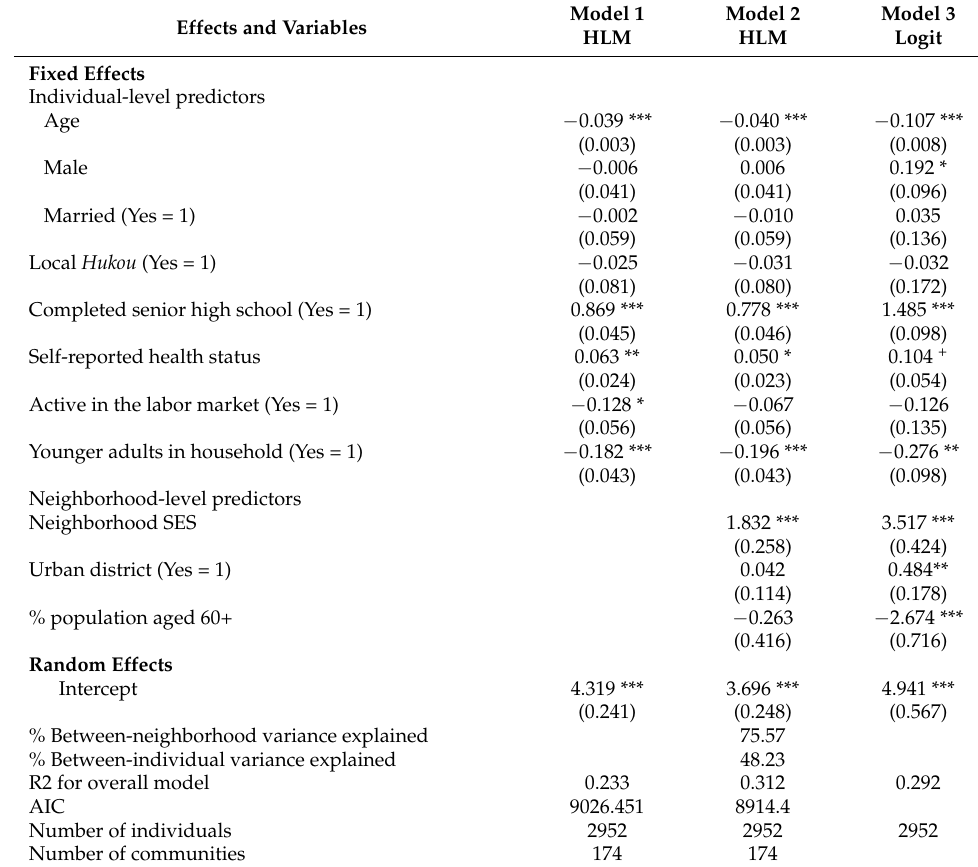
Table 2. Coefficients of multilevel linear regression and logit models of individual and neighborhood characteristics on internet use among older adults in Shanghai: SUNS